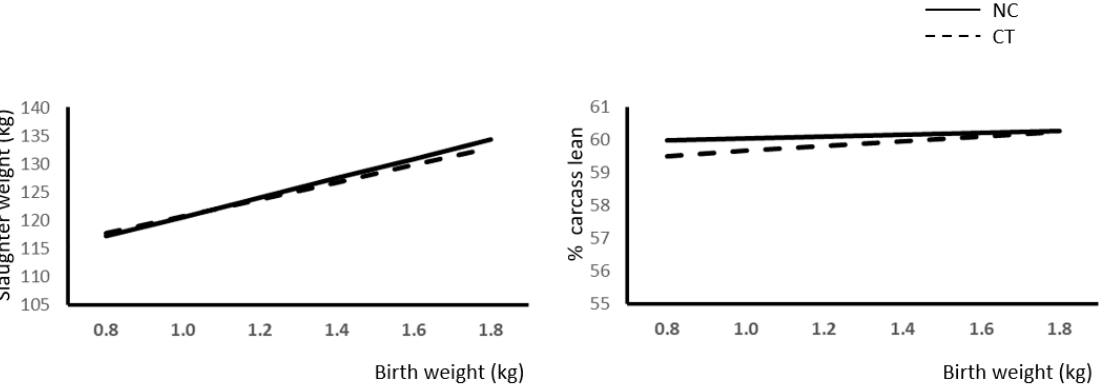
Figure 2. Relationship between birth weight and slaughter weight ( left ) and % carcass lean ( right ) as a consequence of the presence (NC) or absence (CT) of neonatal cares.